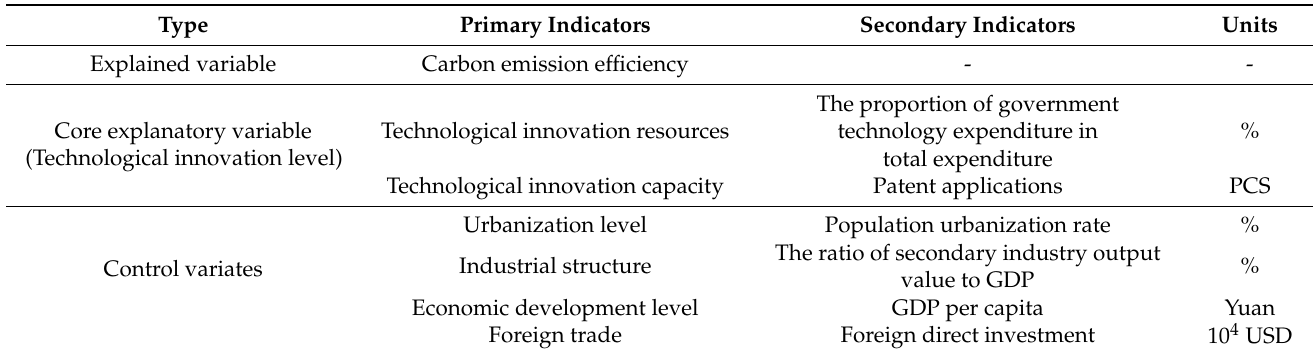
Table 2. The indicator system of influencing factors on